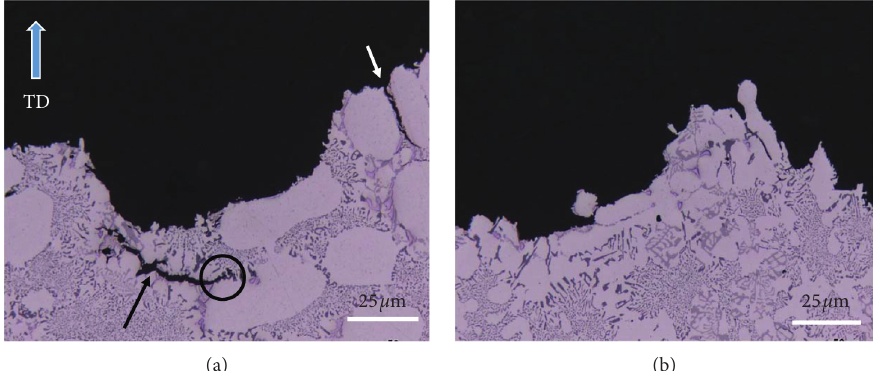
Figure 12: Cross sections beneath the fracture surface of M1S alloy: (a) T6 condition and (b) after stabilization at 250C for 200h. The blue arrow indicates the tensile testing